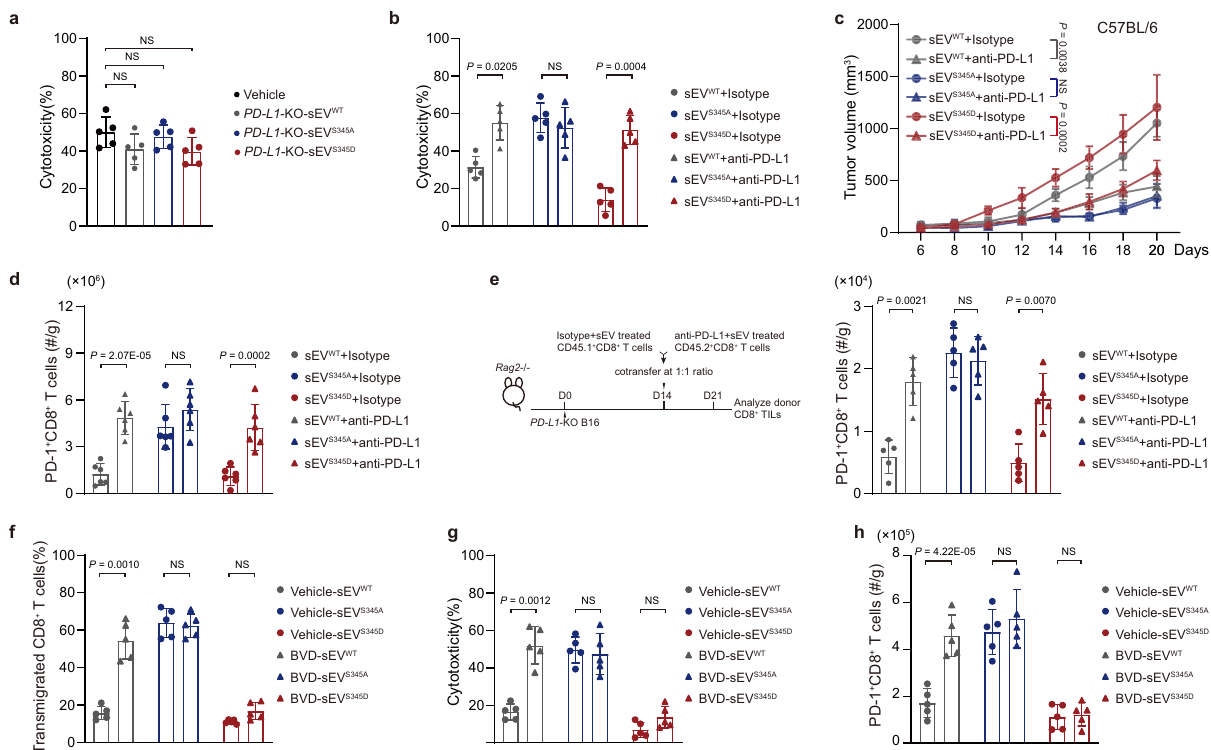
Fig. 5 PD-L1 enriched in exosomes mediated CD8 + T cell suppression induced by HRS phosphorylation. a Cytotoxicity elicited by primed mouse splenocytes treated with or without sEVs derived from PD-L1 -KO B16F10 cells expressing indicated HRS mutants ( n = 5). b Cytotoxicity elicited by primed splenocytes treated with or without sEVs derived from B16F10 cells expressing indicated HRS mutants. sEVs were pretreated with anti-PD-L1 blocking antibody or isotype antibody controls ( n = 5). c The growth of PD-L1 -KO B16F10 tumors in C57BL/6 treated with indicated sEVs from B16F10 cells expressing various HRS mutants. The sEVs were preincubated with isotype control or anti-PD-L1 antibodies ( n = 6). d The number of intratumor PD- 1 + CD8 + T cells (normalized to tumor weight) in tumors in ( c ). e Experimental schema for adoptive CD45.1 + and CD45.2 + CD8 + T cells co-transfer system (left). Number of intratumor PD-1 + CD8 + T cells (normalized to tumor weight) pre-treated with indicated sEVs blocked by isotype (CD45.1 + group) control or anti-PD-L1 (CD45.2 + group) (normalized to tumor weight) (right). n = 5. f Transwells were pretreated with fi bronectin and sEVs from B16F10 cells with or without BVD-523. Percentages of transmigrated mouse CD8 + T cells induced by CXCL9 were accessed ( n = 5). g Cytotoxicity elicited by primed mouse splenocytes treated with sEVs derived from B16F10 cells with or without BVD-523 treatment ( n = 5). h Number of intratumor PD-1 + CD8 + T cells (normalized to tumor weight) in tumor co-grafted by the mixture including indicated sEVs, ECM (Matrigel) and PD-L1 -KO B16F10 cells ( n = 5). The experiments were repeated three ( b – h ) and fi ve ( a ) times independently with similar results obtained. Data represent mean ± s.d. Statistical analyses were performed using one-way ANOVA ( a ) or two-way ANOVA ( b – h ). Tukey ’ s test ( a , c ) and Sidak ’ s ( b , d – h ) were used following ANOVA. Source data are provided as a Source Data fi